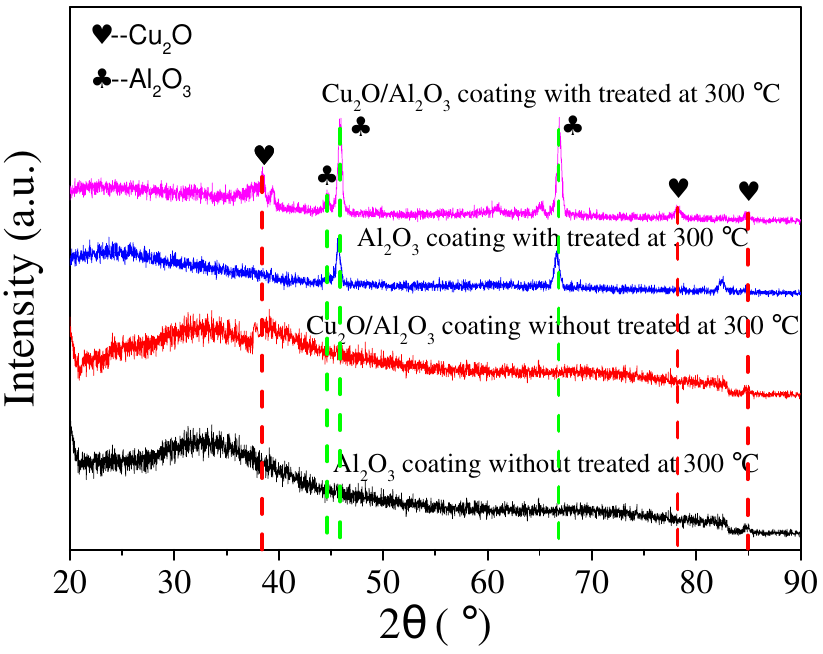
Figure 3. X-Ray diffraction (XRD) patterns of Al 2 O 3 and Cu 2 O/Al 2 O 3 coating before and after being treated at 300 °C.